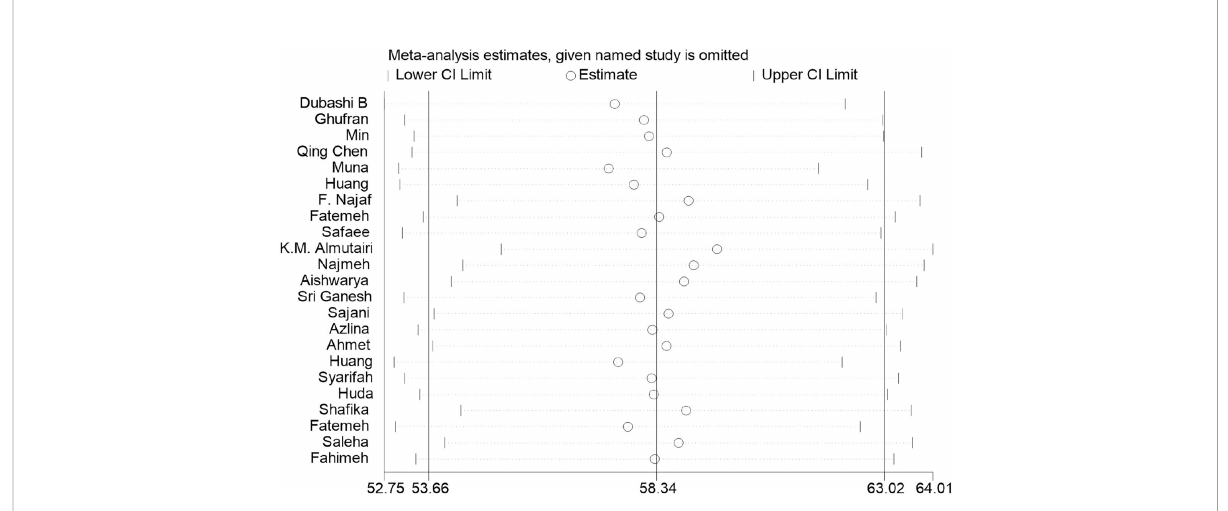
FIGURE 3 Results of sensitivity analysis plot of the global health status.